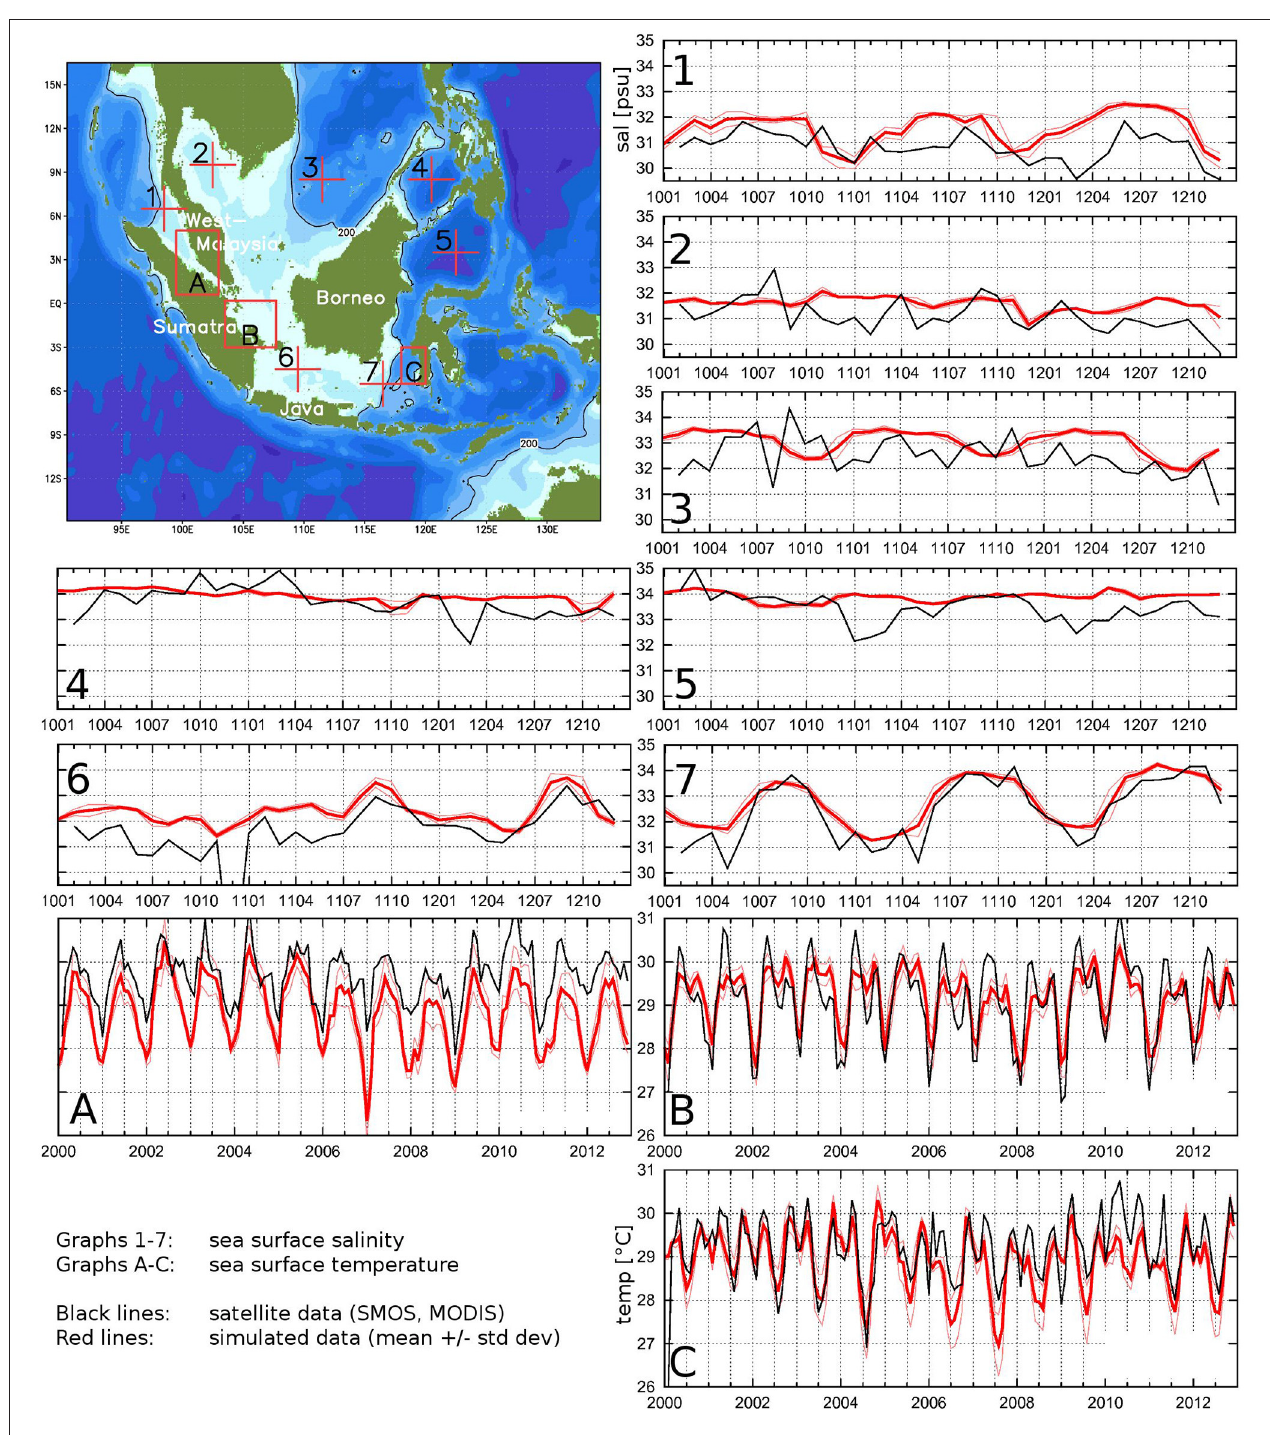
FIGURE 4 | Simulated and satellite derived sea surface salinity (SSS) and temperature (SST) at different positions. Satellite SSS is from SMOS for 2010–2012, satellite SST from MODIS Aqua and Terra for 2000–2012.